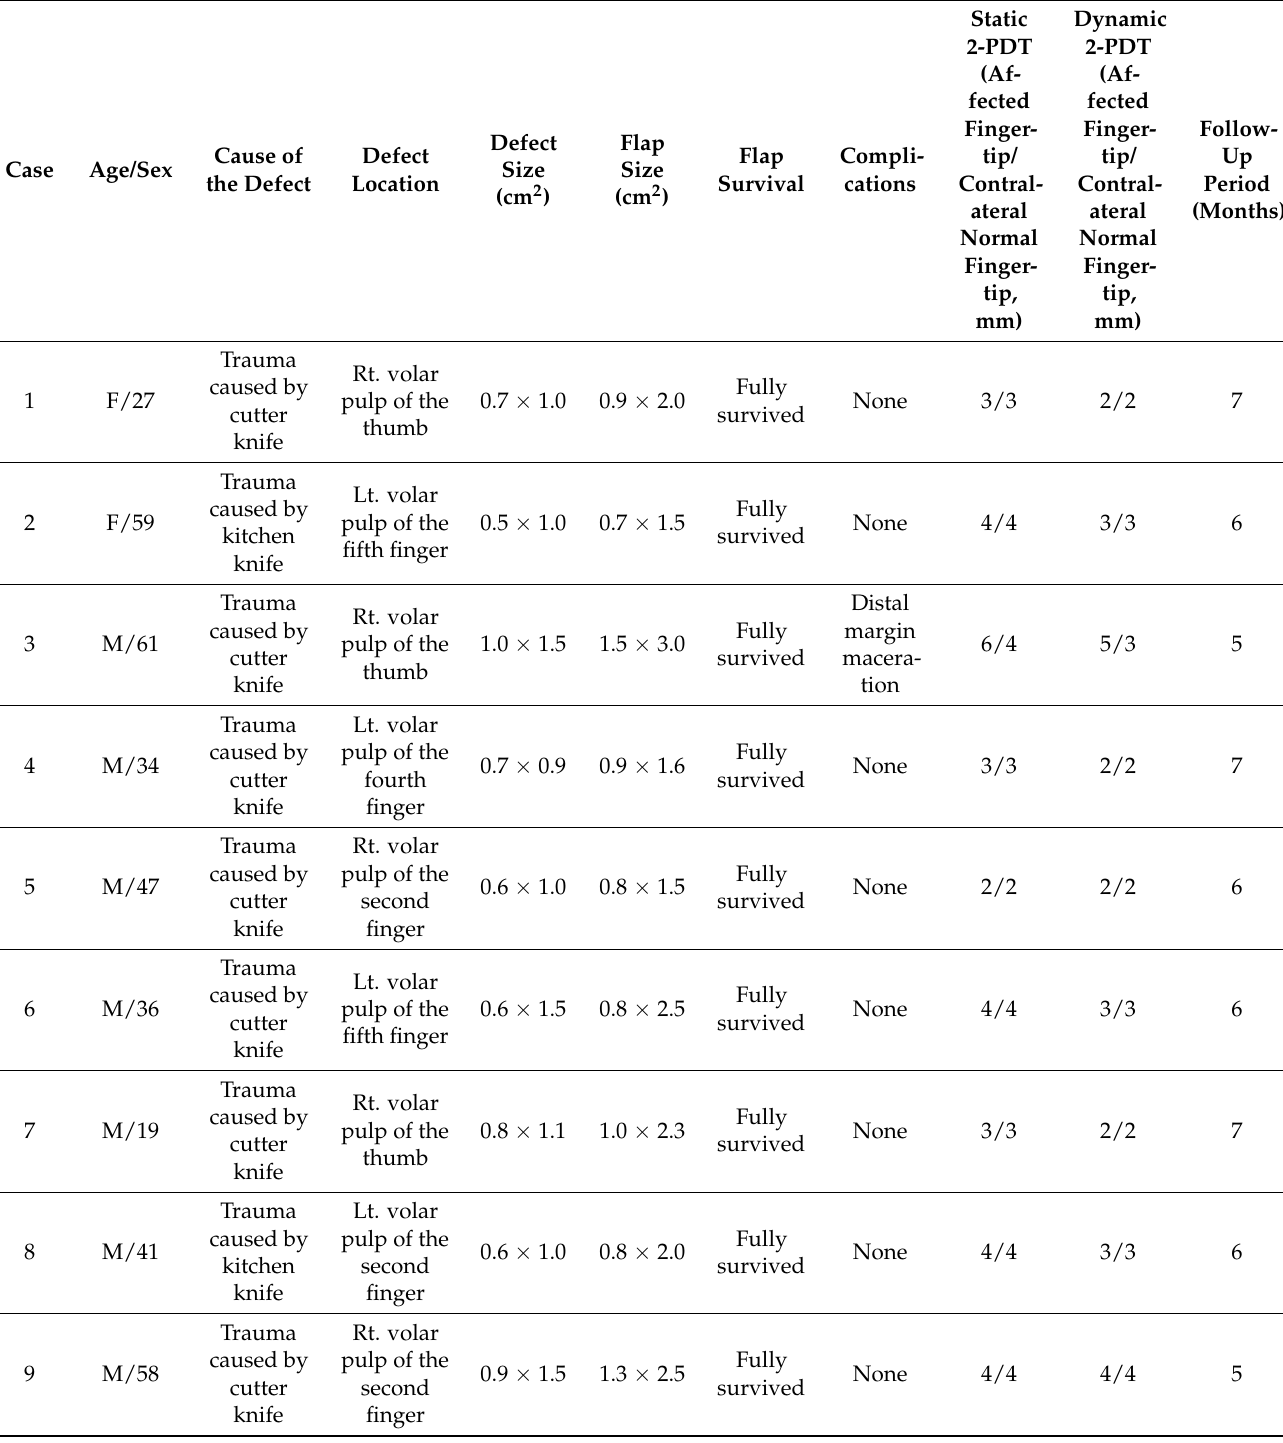
Table 1. Patients’